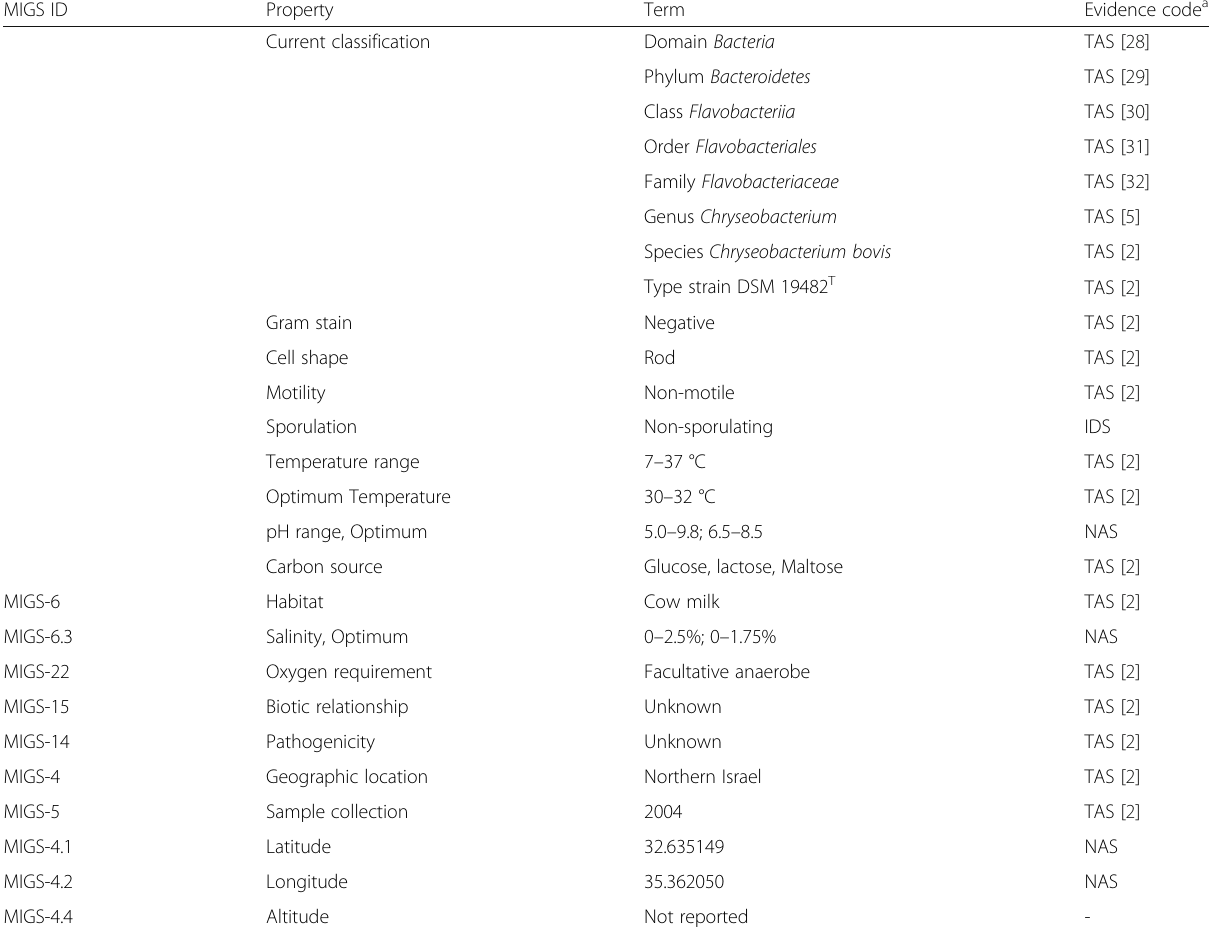
Table 1 Classification and general features of Chryseobacterium bovis DSM 19482 T according to the MIGS recommendations [25], published by the Genome Standards Consortium [26] and the Names for Life database